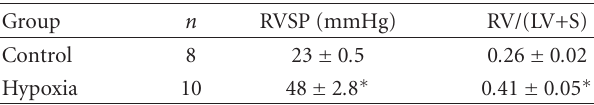
Table 1: Haemodynamic variables and right ventricle hypertrophy